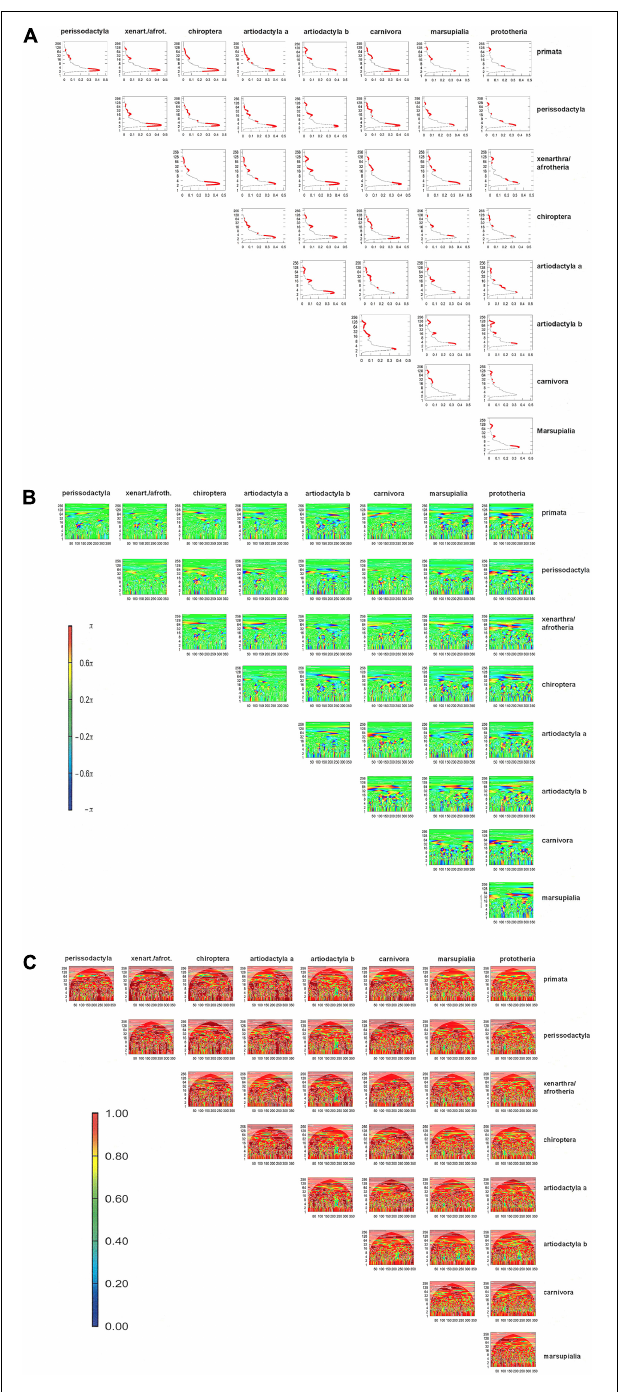
FIGURE 2 | Bivariate wavelet analysis for Osteopontin mutability according to amino acid solubility. Within each subfigure, all comparisons have identical scales for x -axis, y -axis, and–where indicated–for color intensity. (A) Average power plot for amino acid volume. The x -axis (0–0.5) indicates the average cross-wavelet power, the y -axis represents the length of the Fourier period for synchrony. The solid red dots depict significant joint periods at a probability of error of 0.1. (B) Phase difference image. The x -axis is reflective of the amino acid position in the protein (1–356), the y -axis shows the length of the